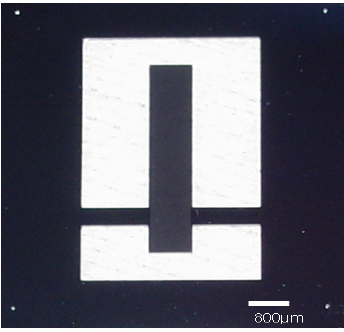
Figure 3. Fabricated magnetostrictive micro mirror.